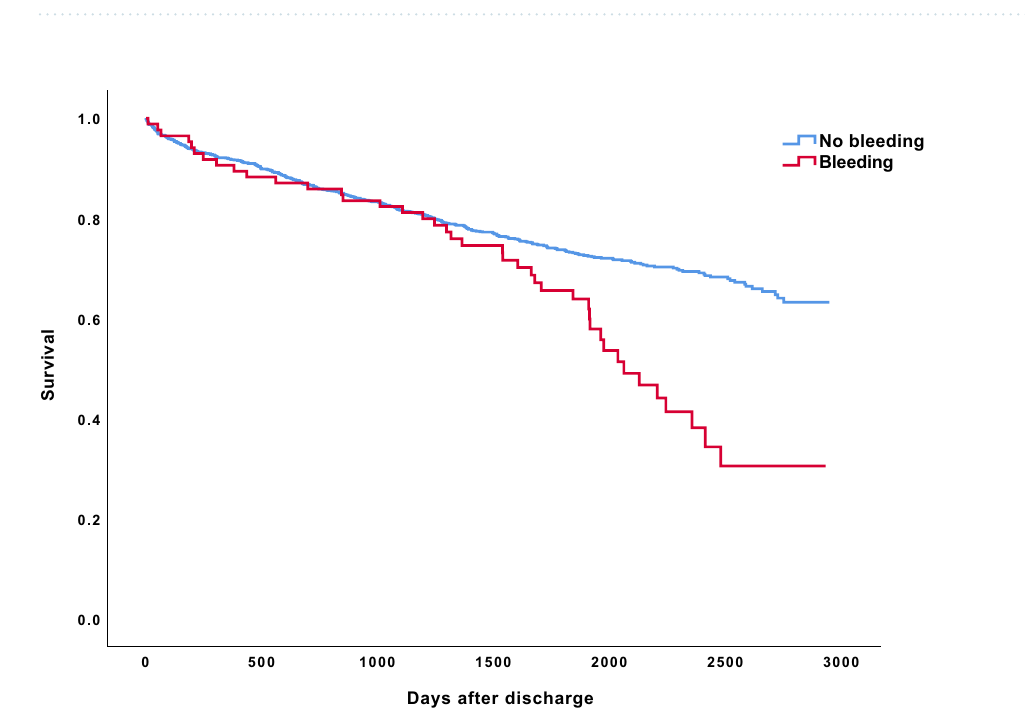
Table 3. Multivariable Cox regression analysis of predictors for bleeding post-discharge after ACS. HR hazard ratio, CI confidence interval, ACS acute coronary syndrome.